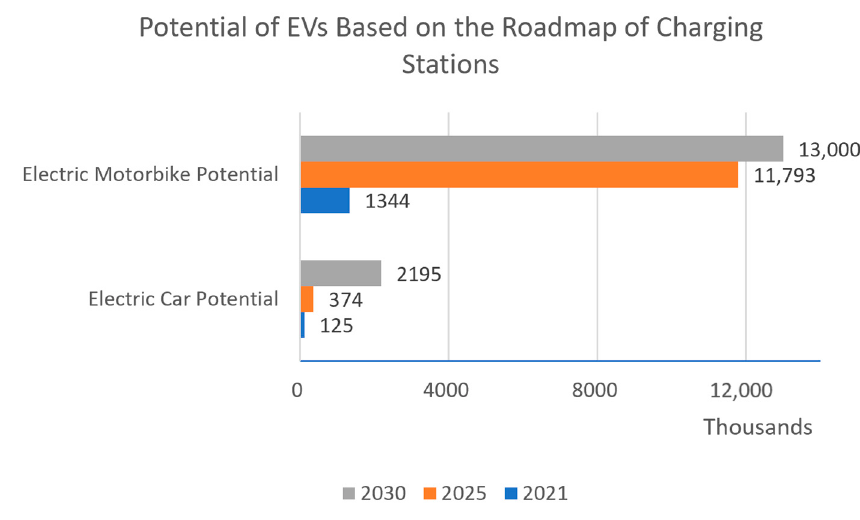
Figure 10. Potential of EVs based on the roadmap in Figure 9 made by KESDM.